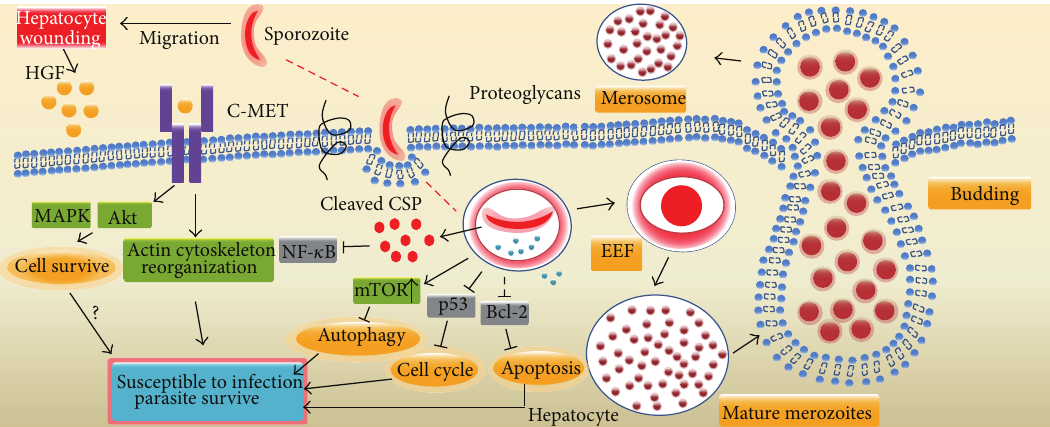
Figure 2: The manipulation of hepatocytes by sporozoites. Sporozoites transmigrate several hepatocytes prior to settling in a final cell. Transmigrated hepatocytes release HGF, which binds to the C-MET receptor, making the hepatocyte susceptible to infection and resistant to apoptosis by upregulation of MAPK, and Akt (left). The interaction of CSP with high levels of HSPGs triggers the cleavage of CSP and encapsulation of sporozoites in parasitophorous vacuoles. Cleaved CSP escapes from the parasitophorous vacuole into the cytoplasm, where it inhibits the NF- 𝜅 B activation and host protein synthesis. Sporozoite invasion upregulates mTOR and downregulates p53, and Bcl-2 which block autophagy, cell cycle progression and Apoptosis, respectively (middle). To avoid destruction by KCs and DCs during release from hepatocytes, merozoites bud from the hepatocytes in merosomes, which are covered with host cell-derived membranes, and PS exposure on the outer leaflet of the dying hepatocytes is blocked